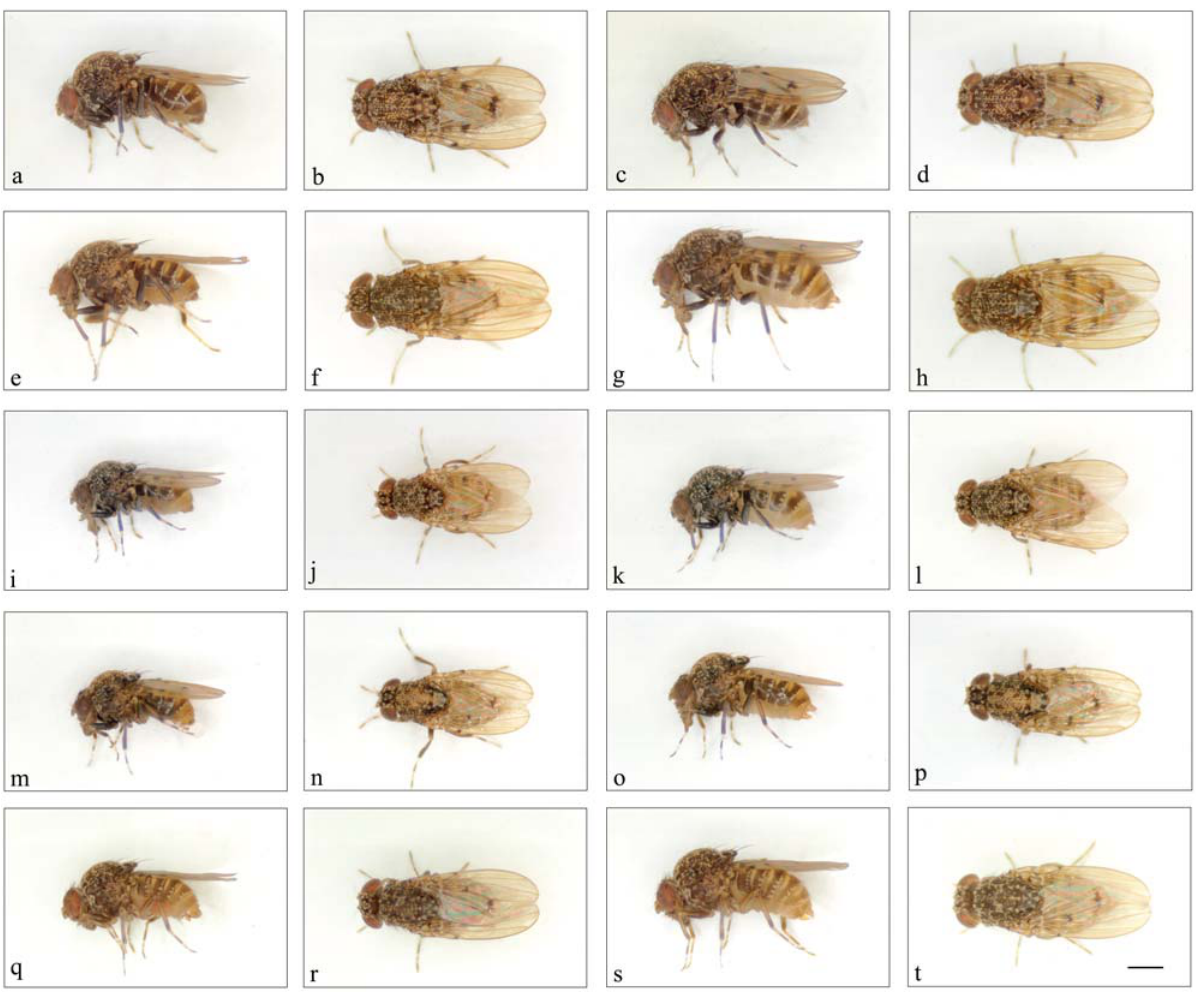
Figure 1 - Photomicrographs of male and female imagines of five Drosophila species from the annulimana group, in left lateral, and dorsal views: a-d, D. aragua [strain H20F1, Santa Maria da Serra, SP, 13-17.VI.1994]; e-h, D. arapuan [strain H81F1, Parque Estadual da Cantareira, São Paulo, SP, 7.IV.1997]; i-l, D. ararama [strain I83F5, Serra do Cipó, Santana do Riacho, MG, 1-4.XII.1998]; m-p, D. gibberosa [strain 1181.0, Mexico]; q-t, D. schineri [strain I18F1, Morro Santana, Porto Alegre, RS, IV.1995]. All pictures were taken and enlarged to the same scale. Scale bar = 1